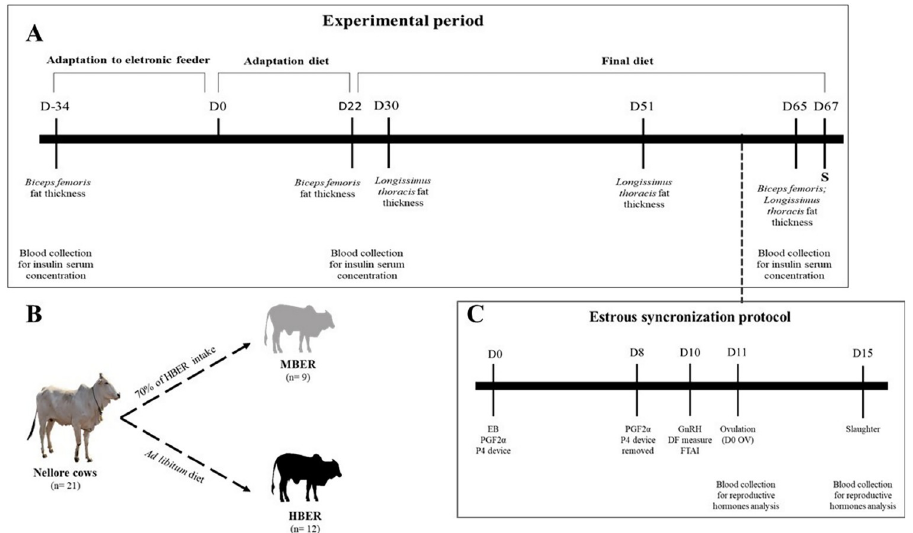
Fig 1. Schematic representation of experimental period. A. Timeline of feedlot period showing days of adaptation to electronic feeder (D-34 to D-1); adaptation diet (D0 to D21) and final diet (D22 to Slaughter (D67); S). During the feeding period the animals were submitted to: Subcutaneous fat thickness analysis of Biceps femoris (D-34, D22 and D65) and Longissimus thoracis (D30, D51 and D65); blood collection for Insulin serum concentration (D-34, D22 and D65); and weekly weighing average daily gain of each animal. B. Two nutritional plans were defined for cows with similar body conformations from a same herd in order to obtain cows with moderate body energy reserve (MBER) and cows with high body energy reserve (HBER) at the end of the experimental period. C. At the end of the experimental period, the animals were submitted to an estrous synchronization protocol (EB: estradiol benzoate, PGF2 α : prostaglandin- 2 α ; P4: progesterone; GnRH: gonadotropin-releasing hormone), dominant follicle (DF) measure, artificial insemination (FTAI) and blood collection for reproductive hormones concentration (Day scheduled for ovulation; D0 OV and